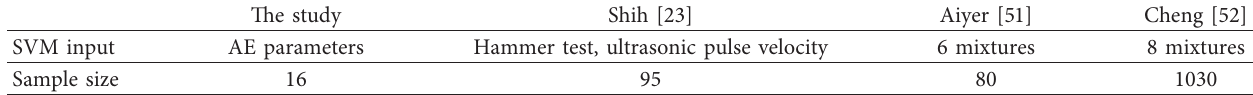
Table 4: . Comparison between the study and others in term of input and sample number. The